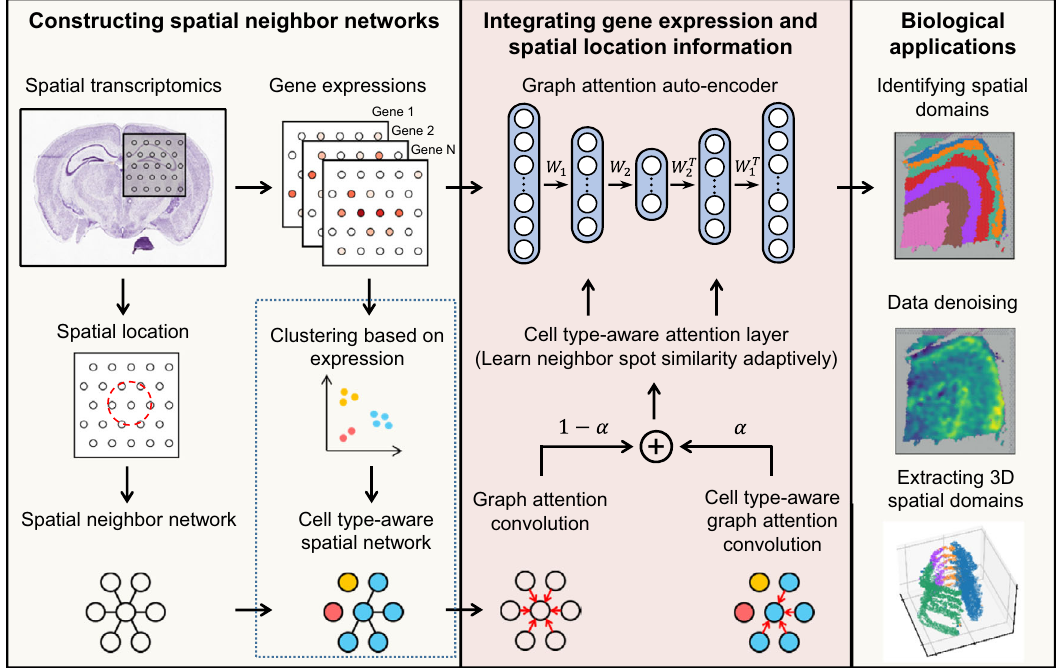
Fig. 1 Overview of STAGATE. STAGATE fi rst constructs a spatial neighbor network (SNN) based on a pre-de fi ned radius, and another optional one in the dashed box for 10x Visium data by pruning it according to the pre-clustering of gene expressions to better characterize the spatial similarity at the boundary of spatial domains. STAGATE further learns low-dimensional latent representations with both spatial information and gene expressions via a graph attention auto-encoder. The input of the auto-encoder is the normalized expression matrix, and the graph attention layer is adopted in the middle of the encoder and decoder. The output of STAGATE can be applied for identifying spatial domains, data denoising, and extracting 3D spatial